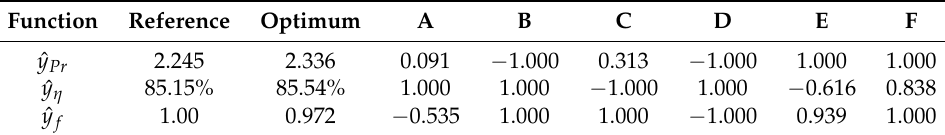
Table 3. Optimum value for objective